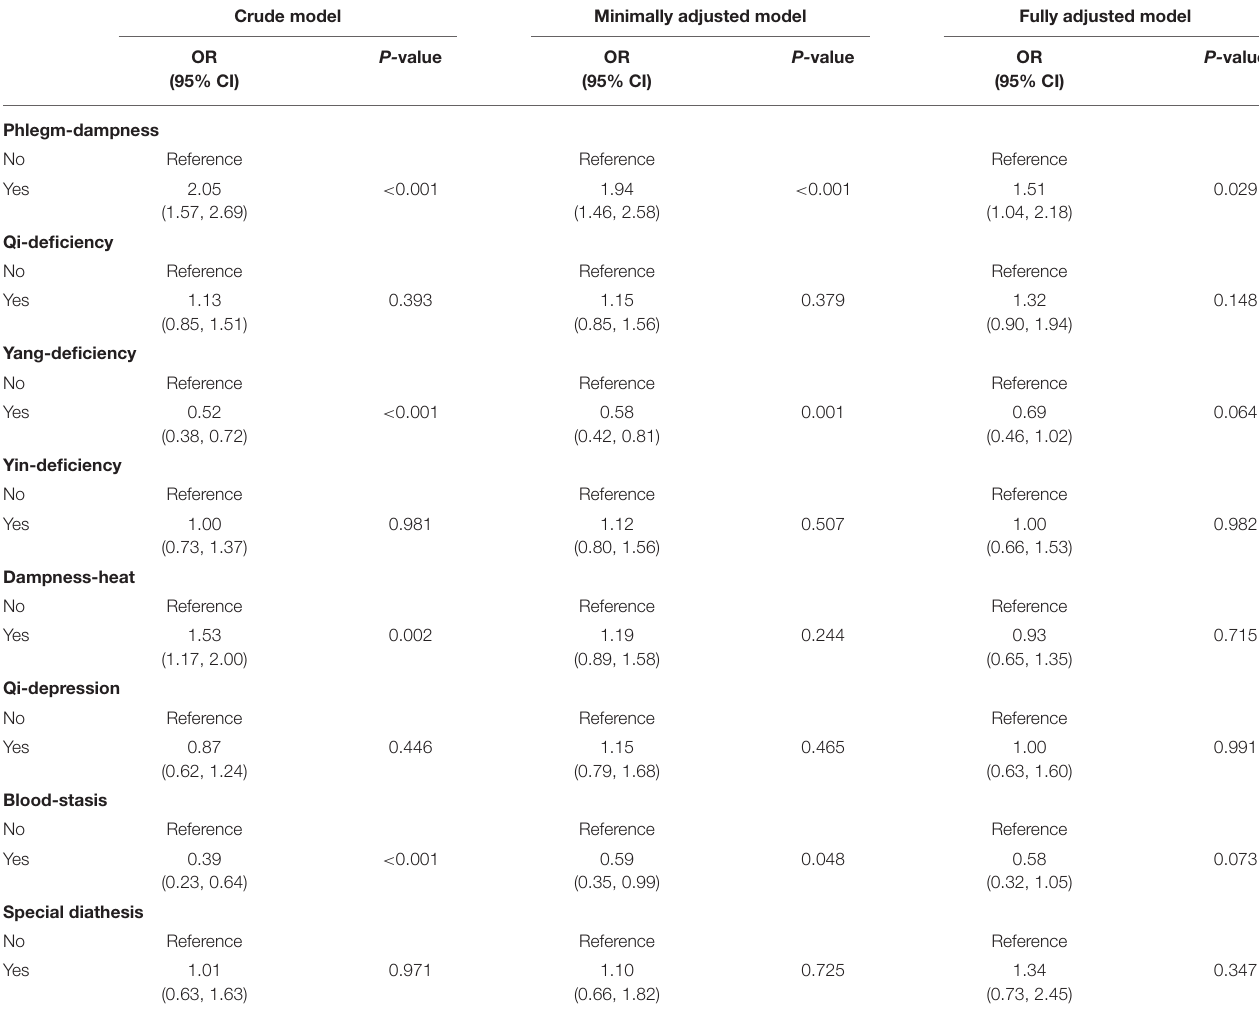
TABLE 3 | Relationship between the phlegm-dampness constitution, seven other biased traditional Chinese medicine constitutions and non-alcoholic fatty liver disease in different models among 1,677